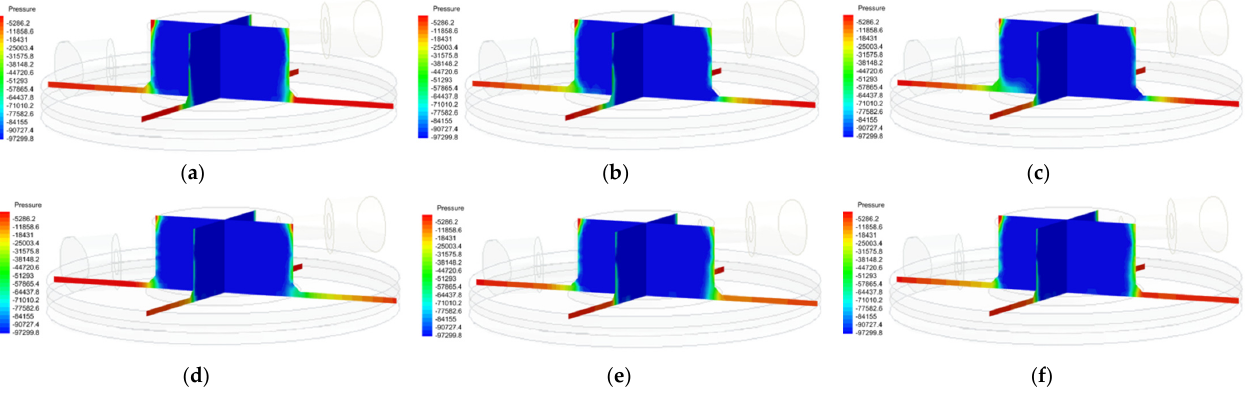
Figure 14. When inlet pressure = 15 MPa, gap = 1.5 mm, the variation of the velocity vector of the